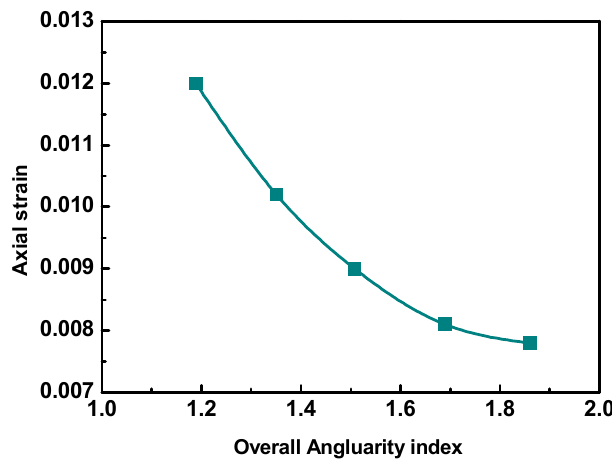
Figure 12. Axial strains with different overall aggregate angularities.